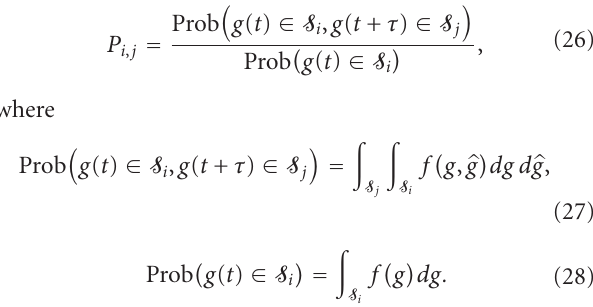
Figure 7: Comparison of approximated and simulated transition probabilities for MIMO-GMD channel capacity (with f D = 30 Hz, τ = 0 . 001 sec and γ = 10dB) in a (2,2)